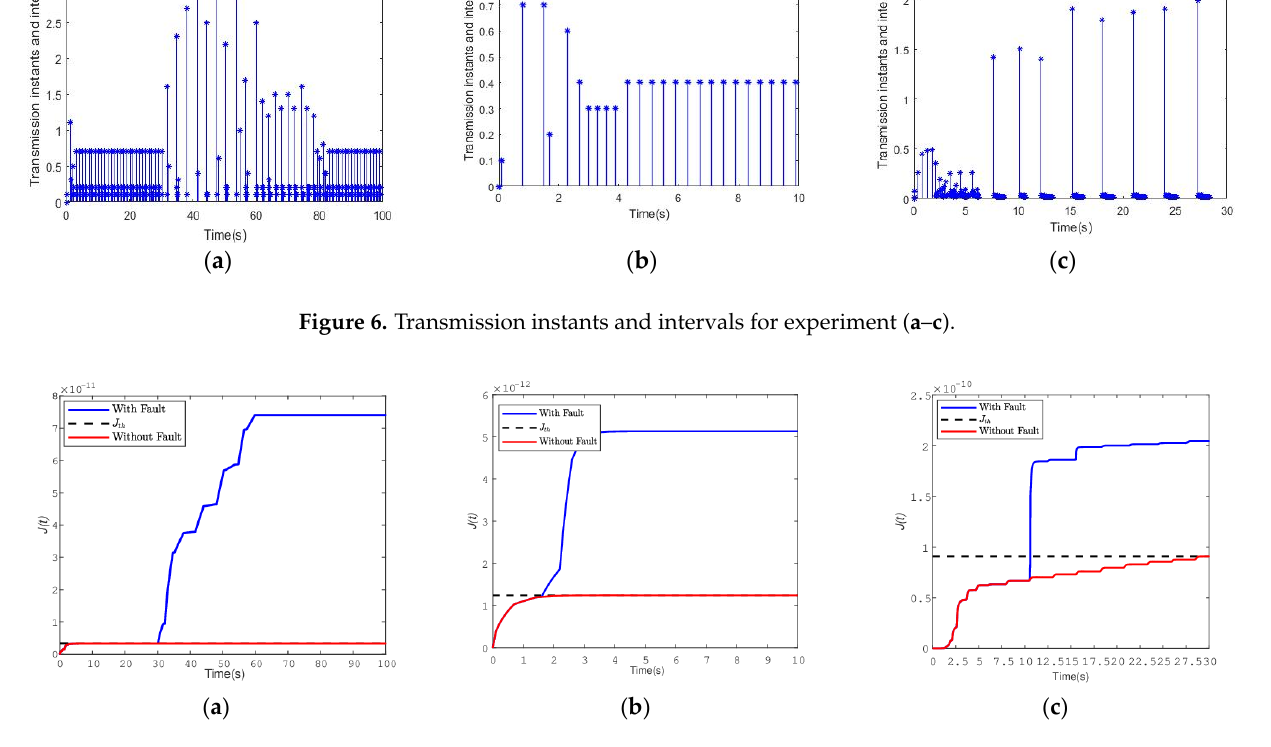
Figure 7. The trajectories of evaluation function with/without fault for experiment ( a – c ). Experiment a uses the same system parameters and fault types as those the in the literature [44]. During the simulation time (100 s) with the sampling period (0.1 s), the cycle triggering time is 1000, and the events triggering time is 239. Simultaneously, the results show that the proposed method obtains a faster detection time. In experiment b, the step signal is used to represent the sudden fault. The final time is 10 s, and the sampling